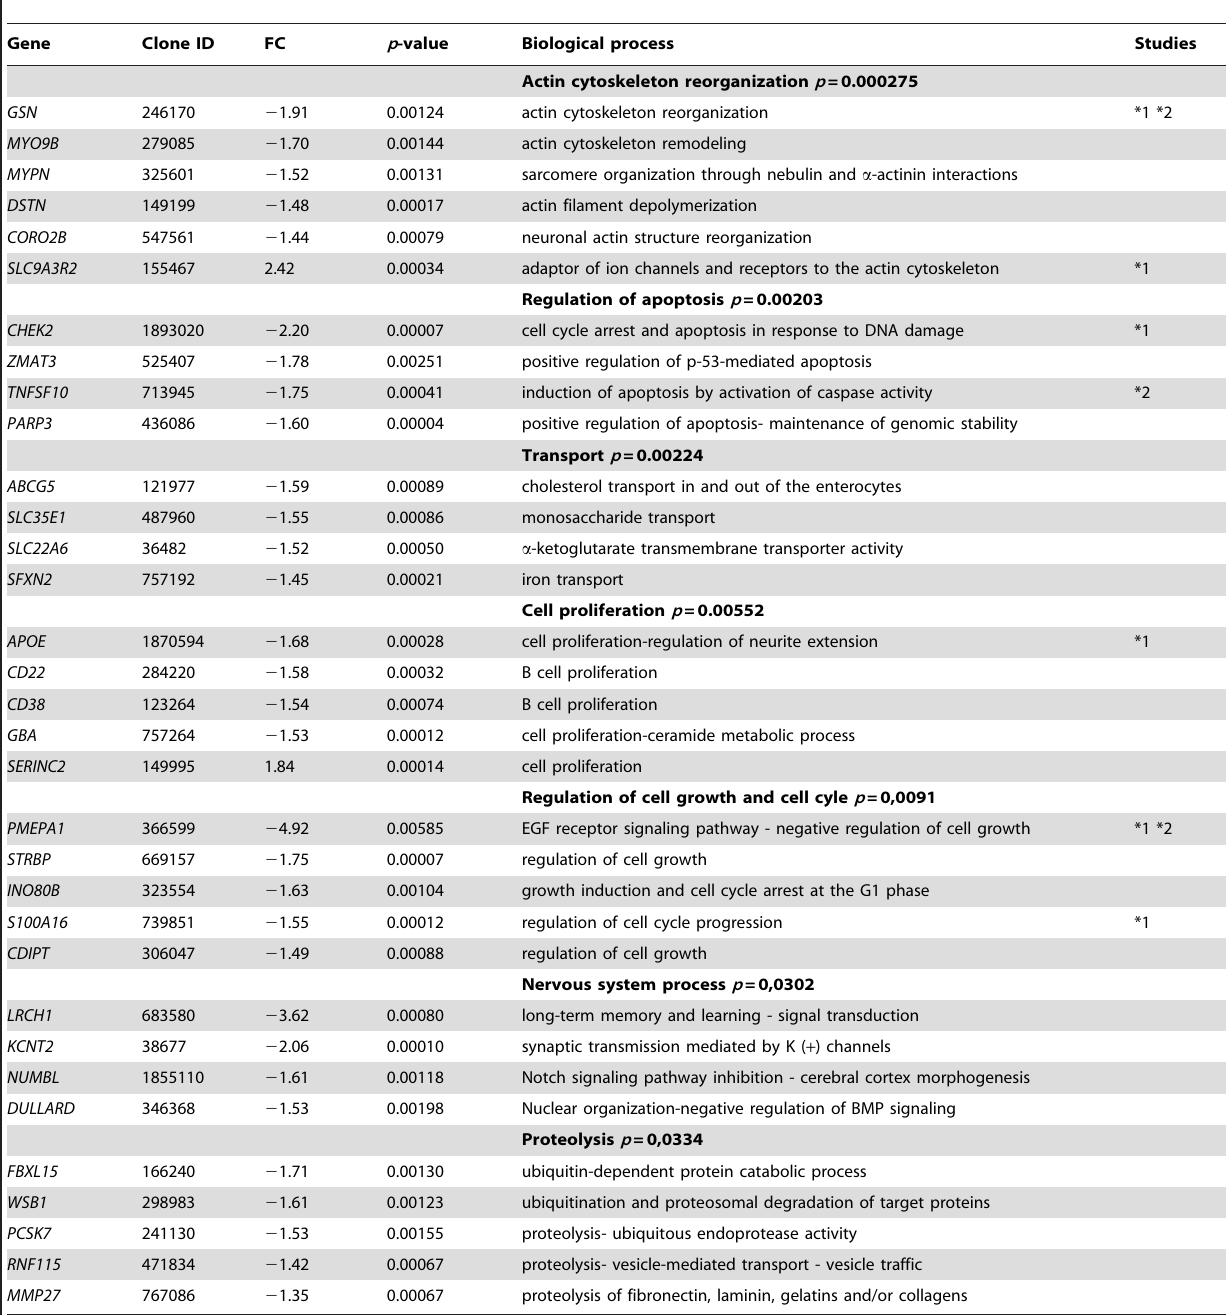
Table 1. Most dysregulated genes in FD hOE-MSCs are involved in seven over-represented cellular processes.